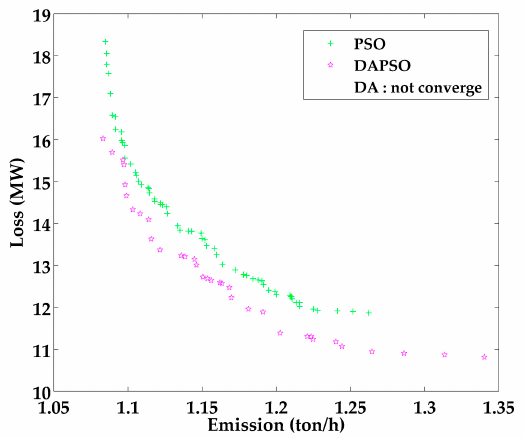
Figure 8. Two-dimensional Pareto fronts when considering emissions and transmission losses as part of the objective function for the IEEE 57-bus system.